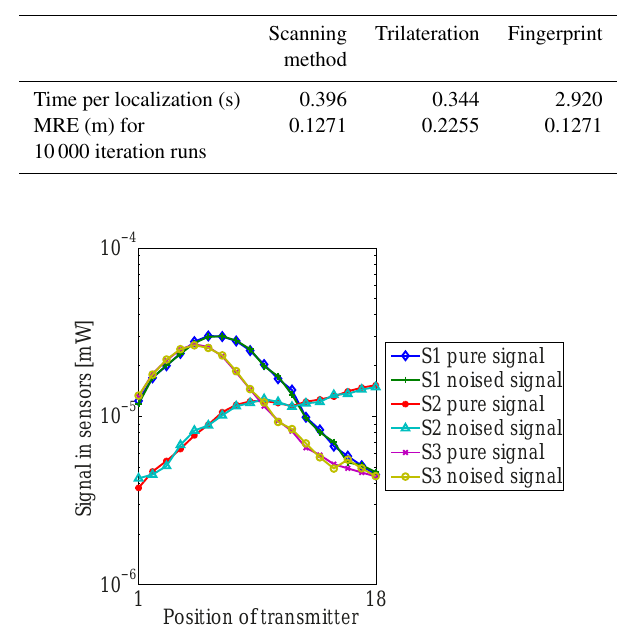
Figure 4. Noise-free signals and signals with additive white Gaus- sian noise simulated at the positions of three receivers (S1, S2, and S3) and presented in logarithmic scale.